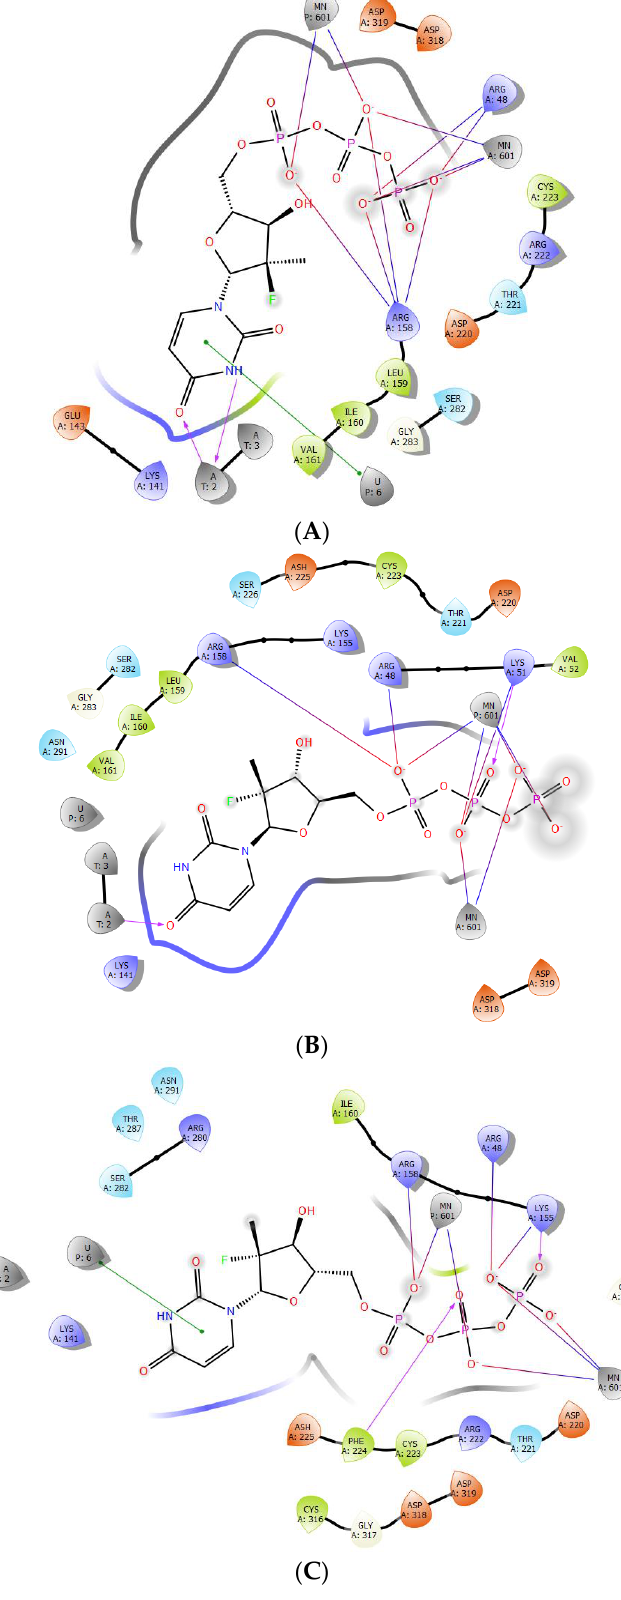
Figure 6. The representative structure of the most dominant structural family for ( A ) WT; ( B ) T179A; ( C ) M289L systems.